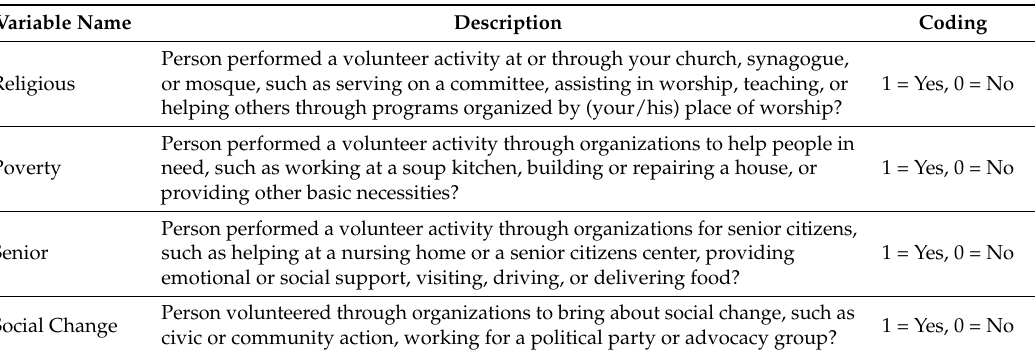
Table 1. Dependent Variable descriptions.